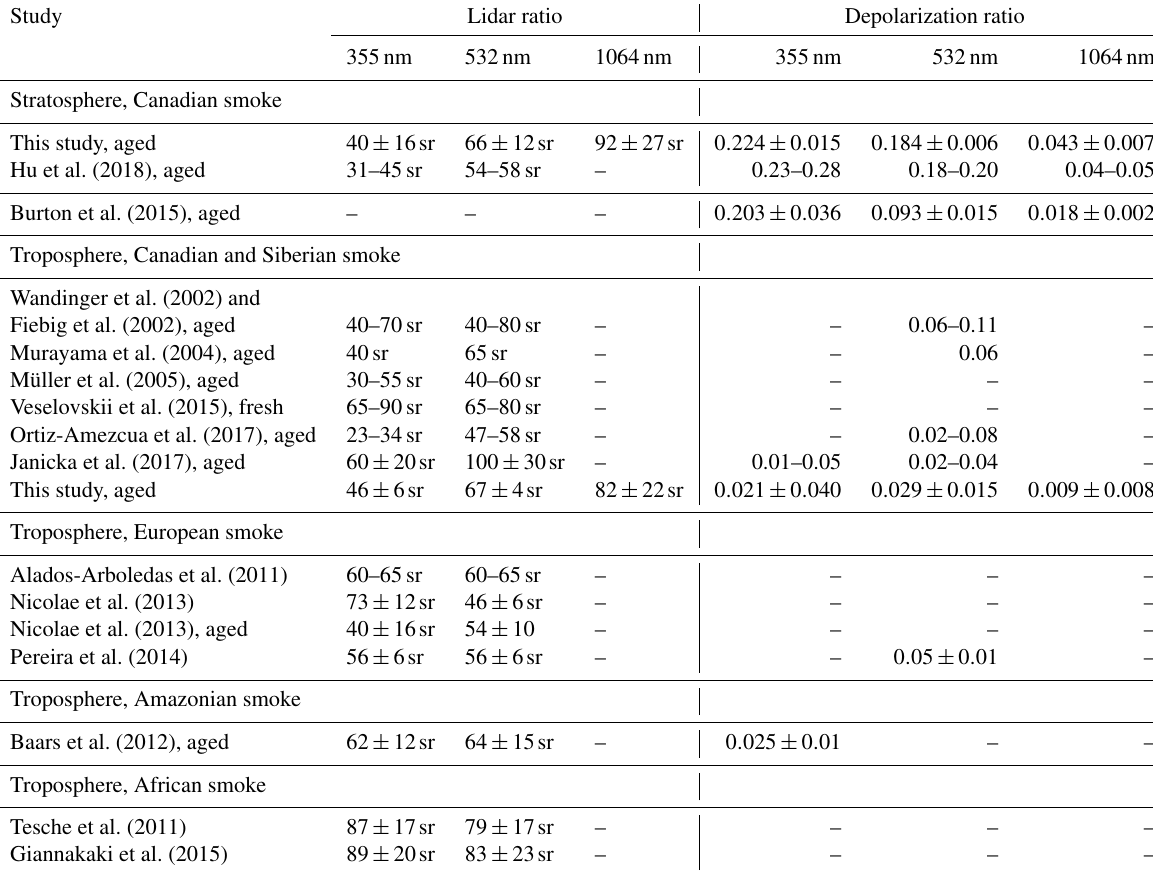
Table 3. Literature overview of multiwavelength lidar observations of smoke lidar ratios and particle linear depolarization ratios of fresh and aged biomass-burning smoke in the troposphere and stratosphere. Our values (indicated by “this study”) are obtained from the BERTHA measurements. For better comparison, the tropospheric triple-wavelength depolarization ratio observation of Burton et al. (2015) performed in aged northwestern American smoke is listed in the third data row, i.e., before the “Troposphere” sections. The stratospheric lidar and depolarization ratios of Hu et al. (2018) were measured at Lille, northern France, on 24–31 August 2017. The range of mean values of six lidar sessions at Lille (on 4 different days) is given, retrieval uncertainties are of the order of 10–20sr for the lidar ratios and 0.01 (1064nm), and 0.03–0.04 (355 and 532nm) in the case of the depolarization